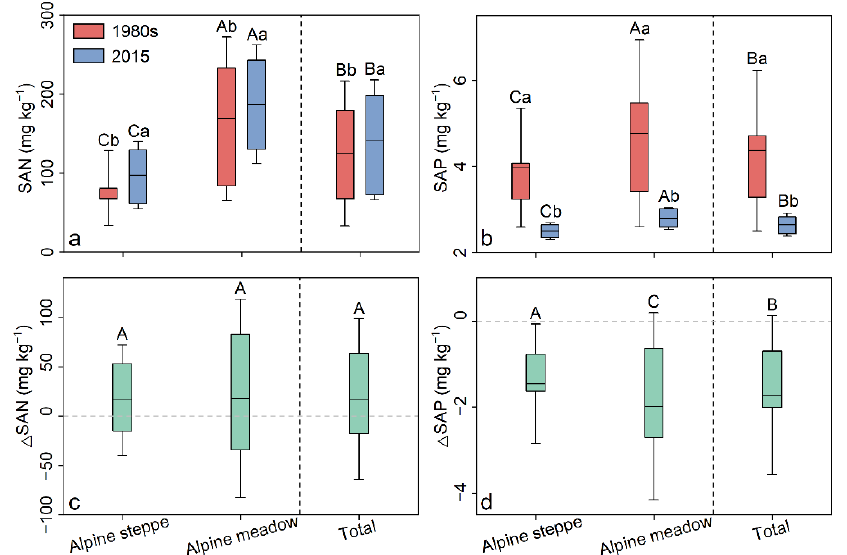
Figure 5. SAN and SAP contents of alpine grasslands on the QZP in the 1980s and 2015 ( a , b ), and their corresponding net changes ( c , d ). The right side of the dotted line indicates the whole alpine grasslands, and the left side of the dotted line indicates the alpine meadows and alpine grasslands. The boxes denote the 25th and 75th percentiles, the transverse lines in the boxes denote the average, and the boxes’ error bars denote the standard deviation. The same letters above the boxes indicate non ‐ significant differences ( P > 0.05), with the upper ‐ case representing comparisons between groups and the lower ‐ case representing comparisons within groups.